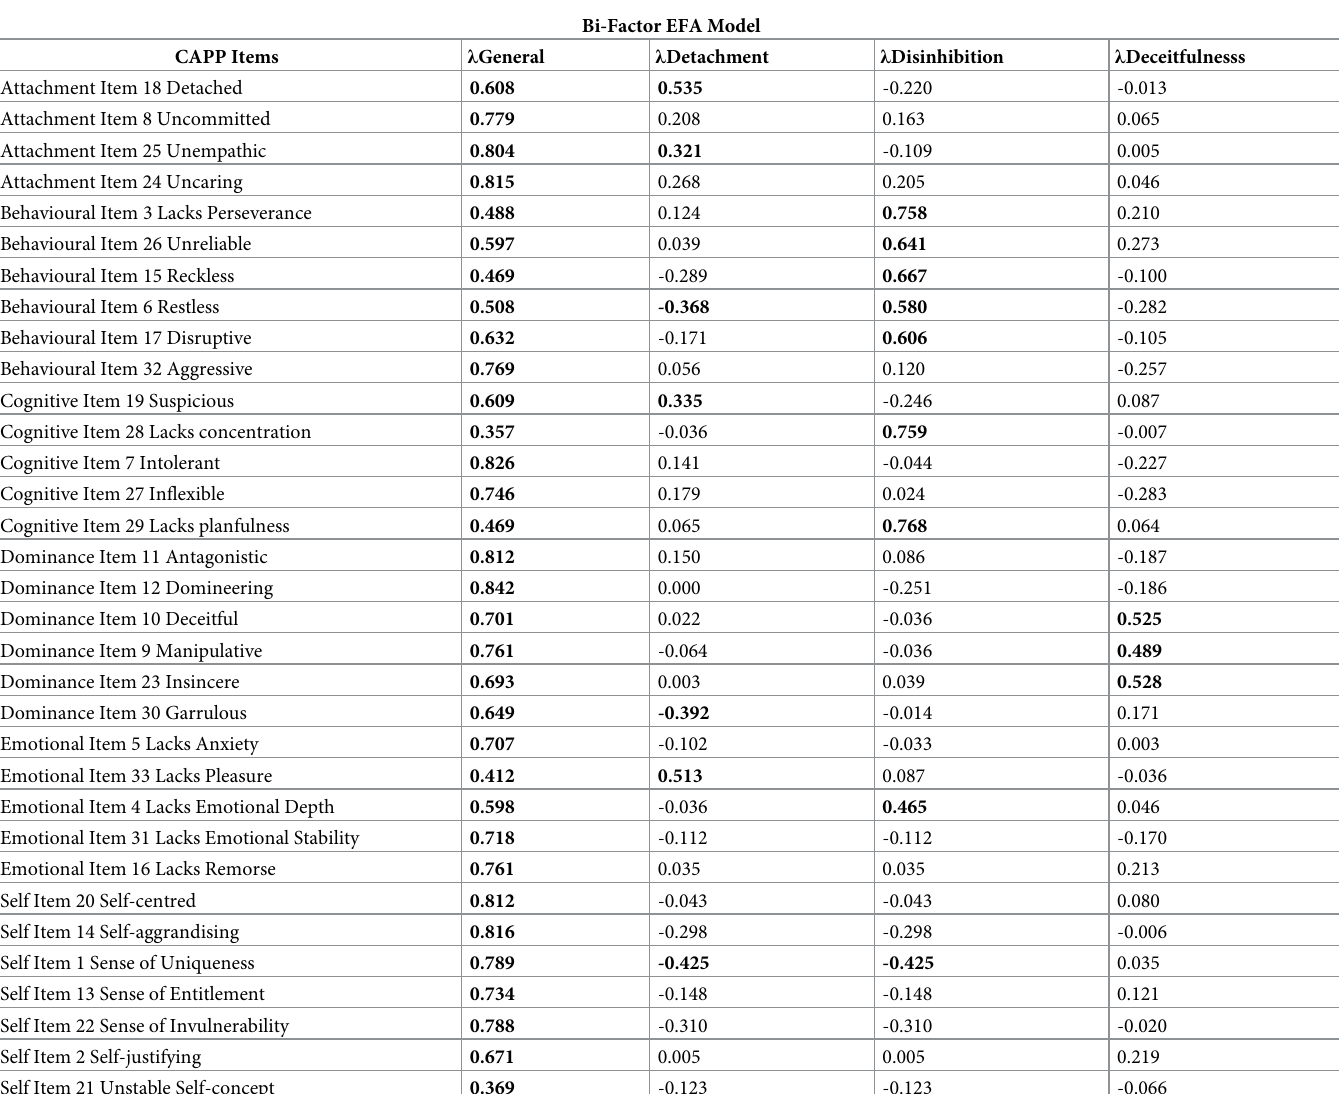
Table 6. Fully Standardized Factor Loadings for Bi-Factor EFA